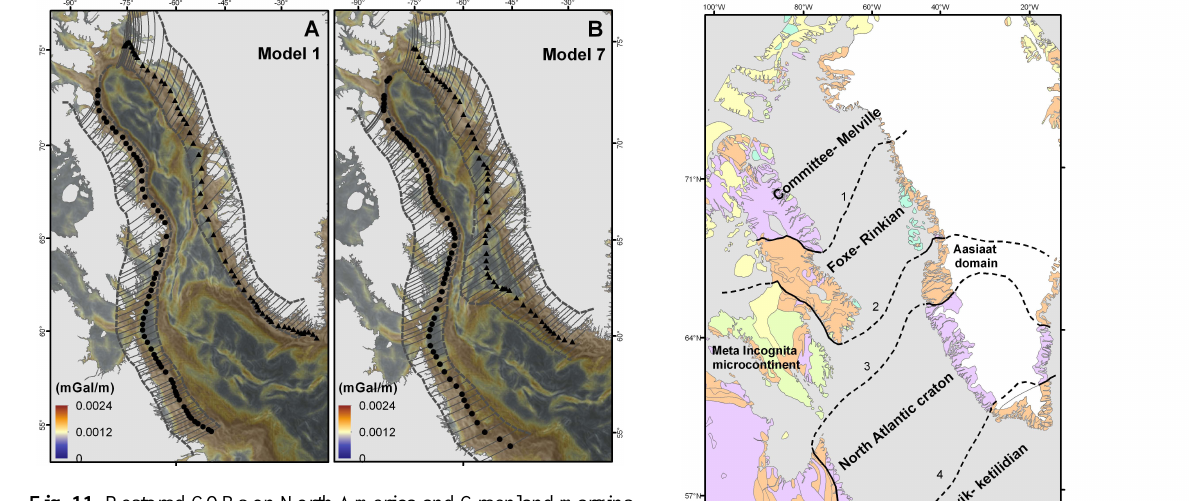
Fig. 11. Restored COBs on North America and Greenland margins together with small circle paths showing the direction of restora- tion. The dashed lines are the UCCL and COB lines before the restoration was performed. The background is total horizontal gra- dient of Bouguer gravity map. Model 1: Srivastava and Roest (1989) COBs. Model 7: our preferred model assuming the COB in the range of COT, and UFZ as leaky transform fault in Davis Strait. Restored COB locations: triangles – Greenland margin; circles – North American margin. Fig. 12. Geological map of North America and Greenland